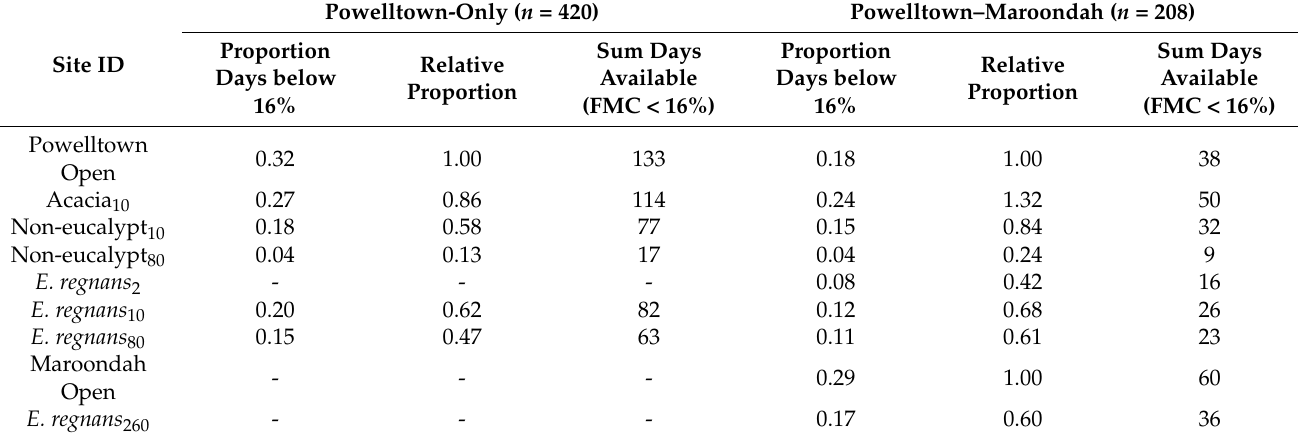
Table 4. Summary of the proportion of mean daily FMC values less than 16% relative to the number of days in each timeseries, the proportion less than 16% relative to the local control weather station and the total number of days fuels were available for each timeseries.